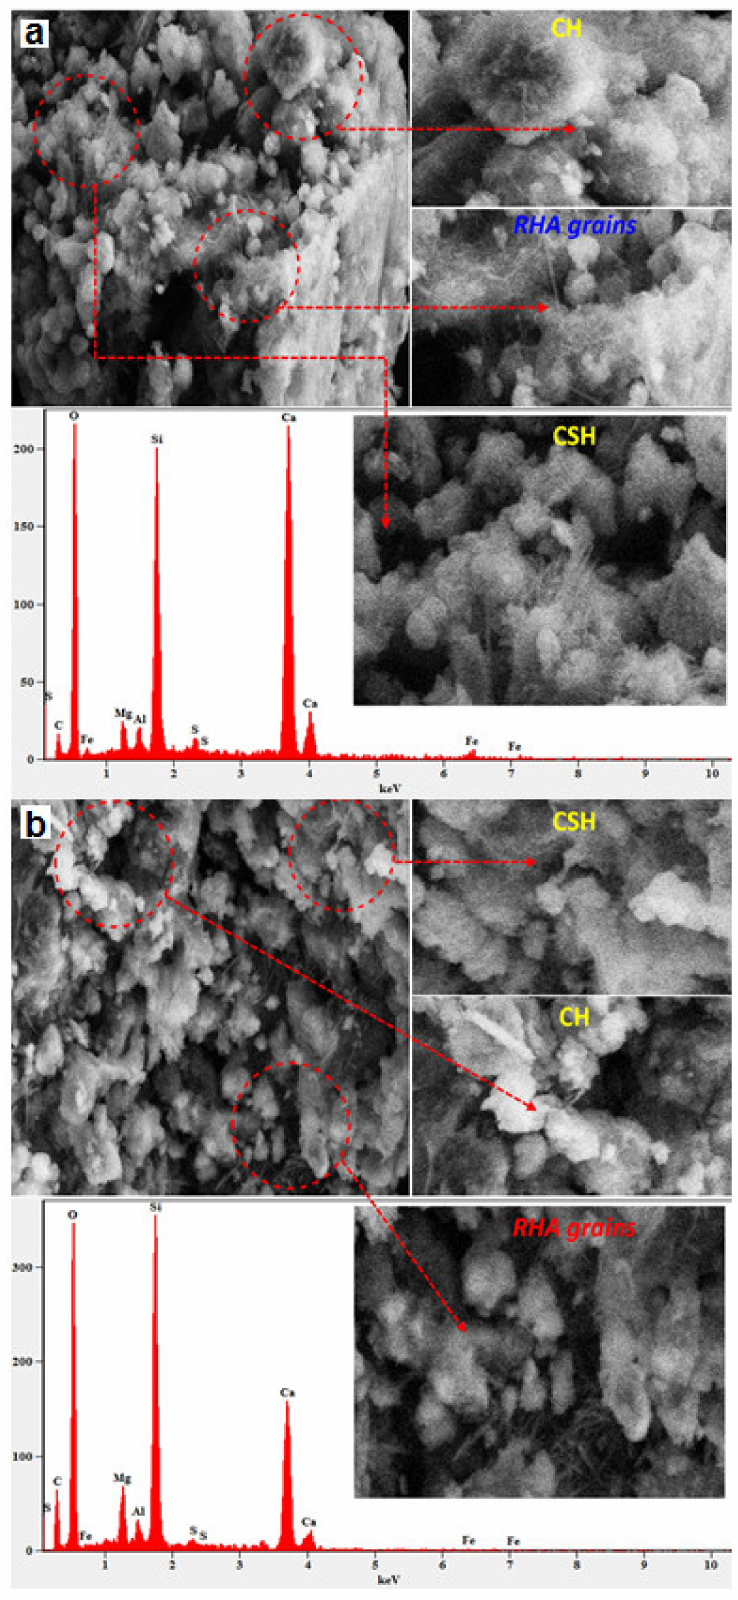
Figure 14. SEM and EDX result of LRA mortar. ( a ) 7 days and ( b ) 28